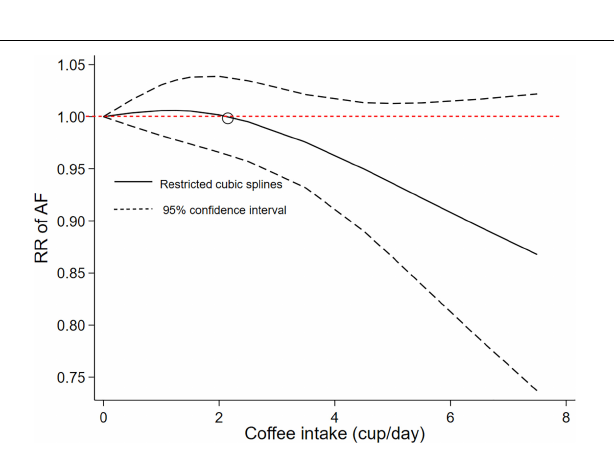
FIGURE 4 | Dose–response association of coffee intake with the risk of atrial fibrillation assessed by a cubic spline